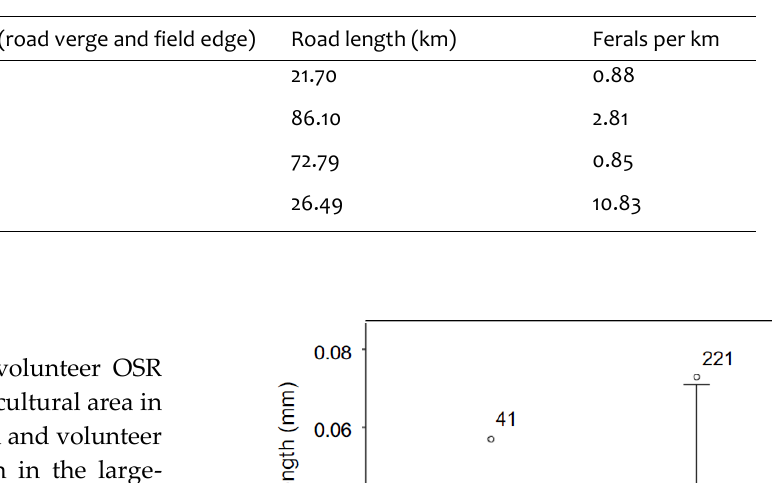
Table 3. The number of feral OSR individuals on road verges and field edges, road length and feral rape individuals/km divided into the different road categories.